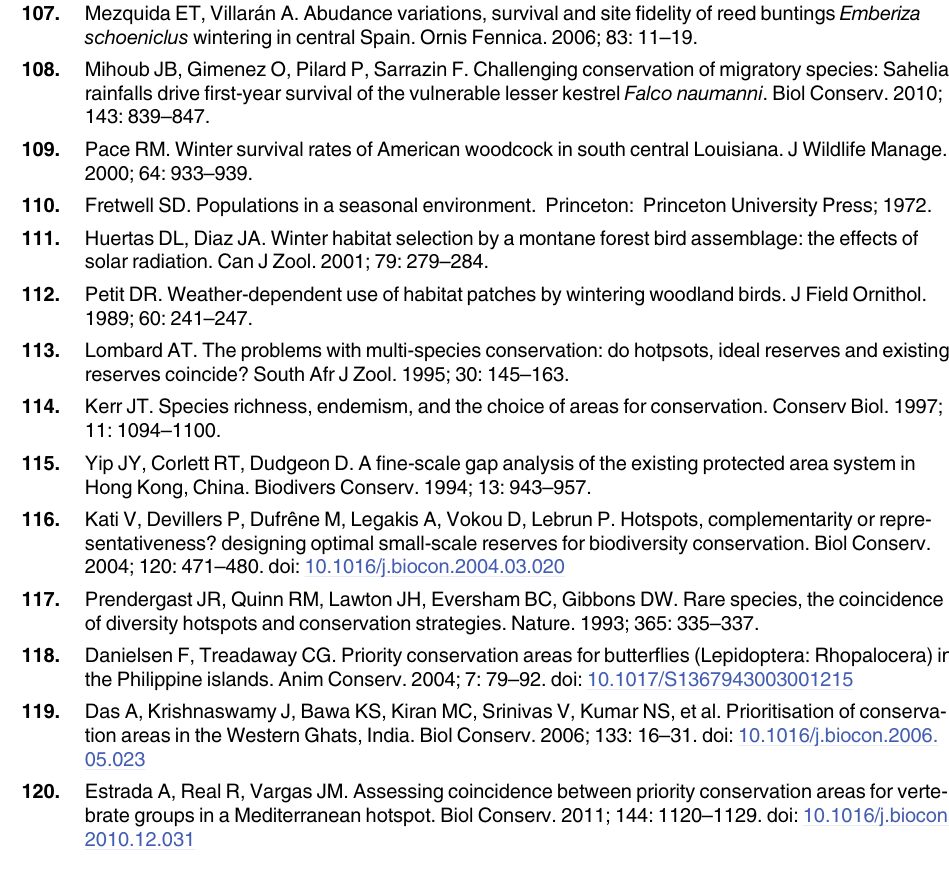
PLOS ONE | DOI:10.1371/journal.pone.0149323 February 26,